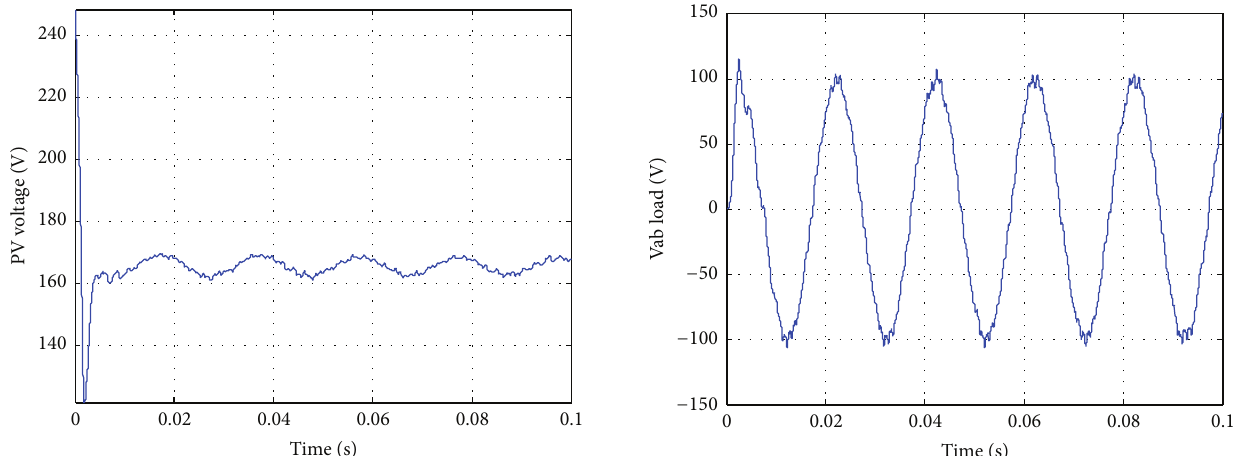
Figure 20: AC load voltage